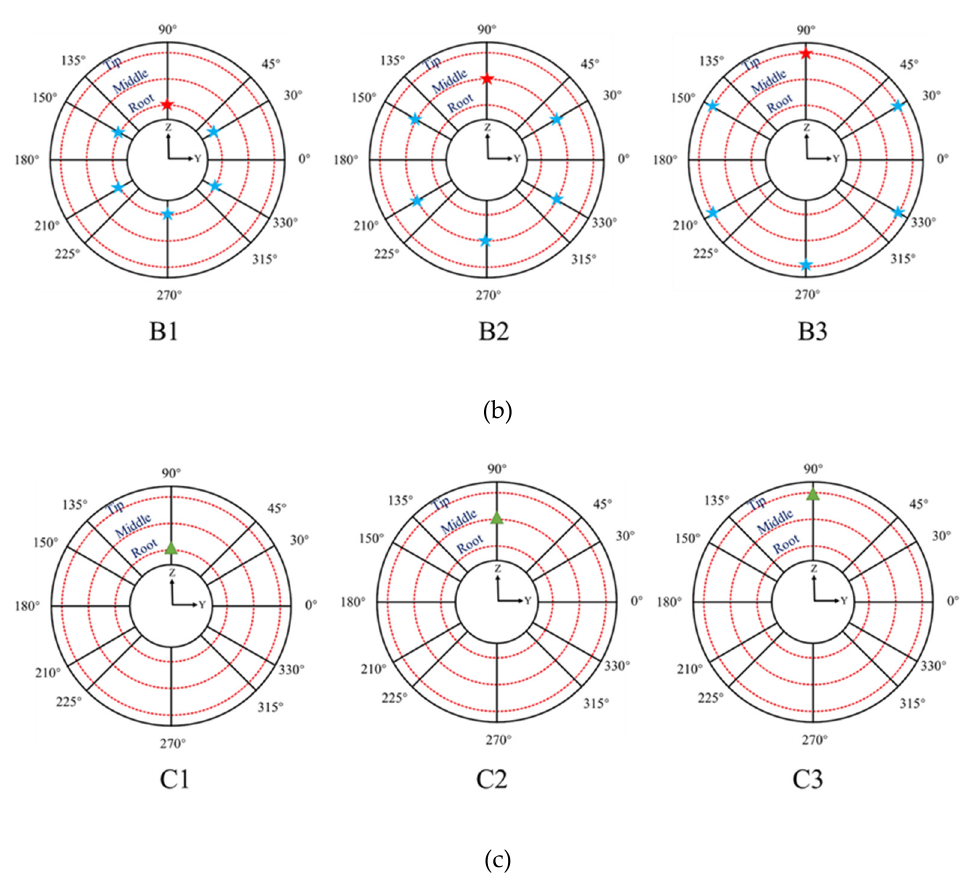
Figure 3. The different bird-strike cases: ( a ) small flocking birds, ( b ) medium flocking birds, ( c ) single large bird.